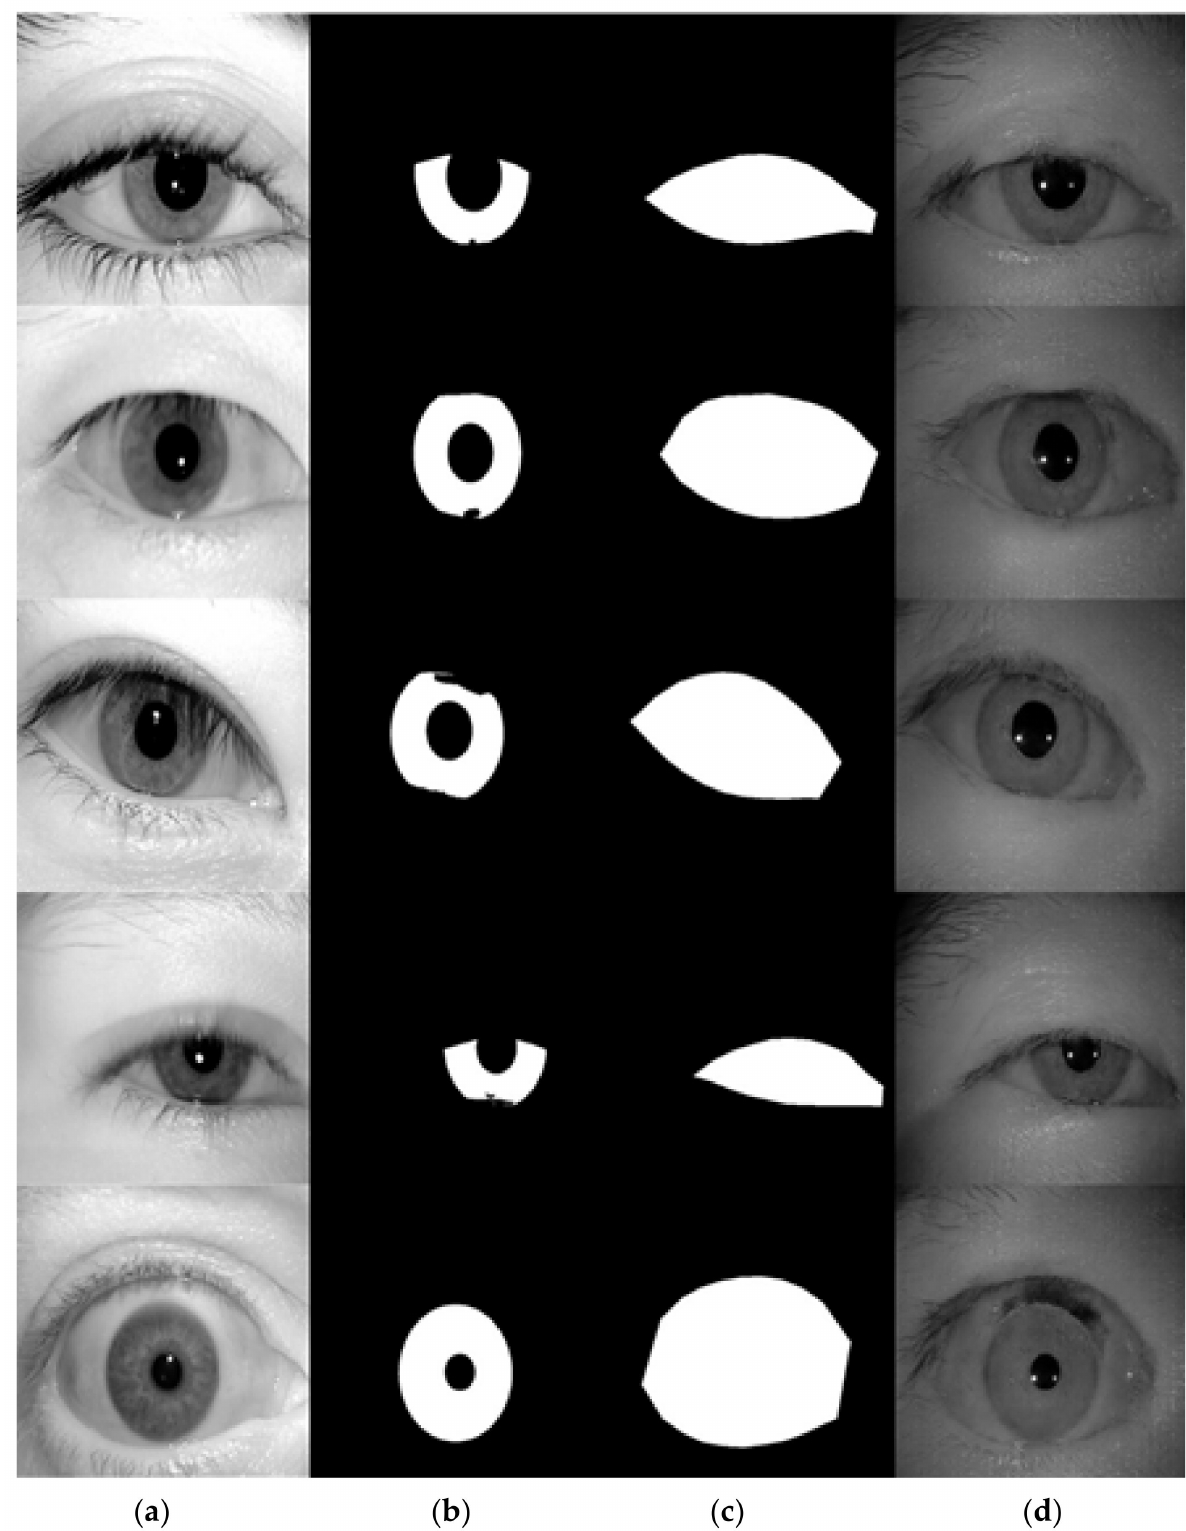
Figure 16. The examples of generated images (trained with ICE dataset, without glasses). ( a ) original iris image; ( b ) ground-truth label for iris; ( c ) ground-truth label for periocular region; ( d ) generated images using ( b , c ) as the conditional inputs to the proposed image generation